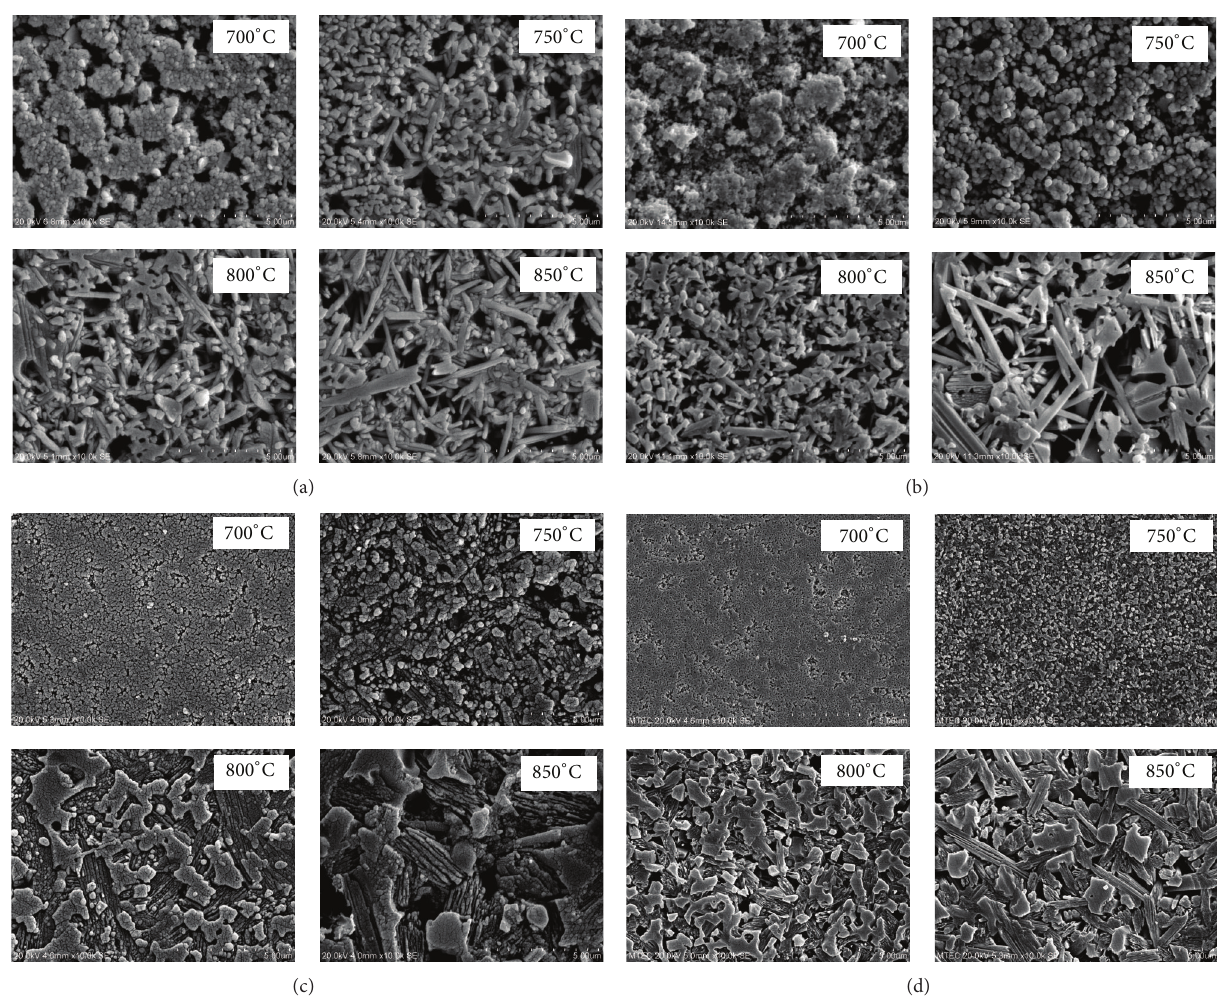
Figure 5: SEM micrographs of (a) LD1, (b) LD2, (c) LD3, and (d) LD4 after heat treatment at different temperatures for 2 hrs. Table 4: The comparison on calculated flaw sizes of Glasses LD1–LD4 after being heat-treated at 750 ∘ C, 800 ∘ C, and 850 ∘ C. Glasses